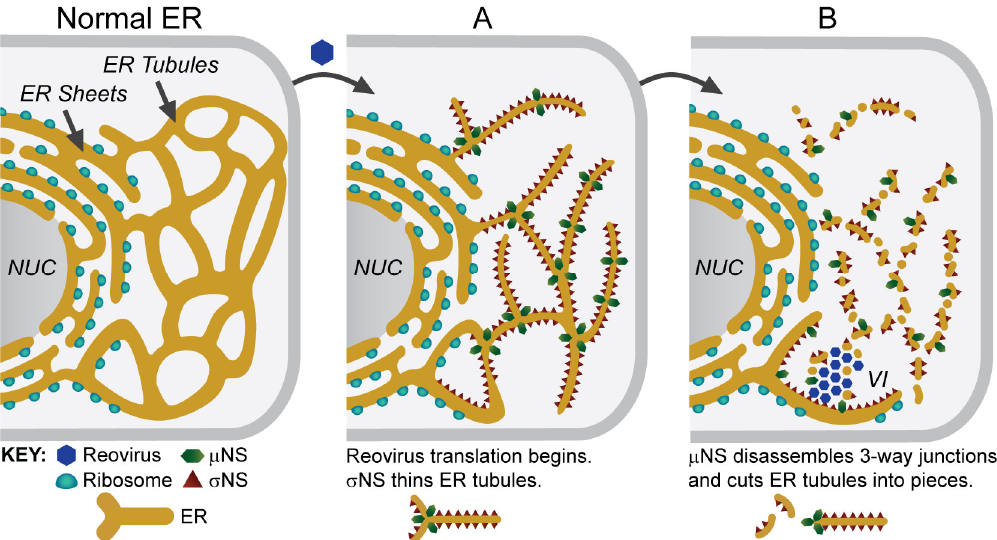
Figure 4. Model of ER remodeling and VI biogenesis. The ER in uninfected cells is composed of sheets and tubules. ( A ) In reovirus-infected cells, σNS binds to the ER tubules and transforms them into thin structures. ( B ) µNS binds to these thin tubules and triggers their fragmentation. Small tubules and vesicles coalesce to form the VI. The schematics at the bottom demonstrate how σNS and µNS might remodel the ER. NUC—nucleus. Modified from Tenorio et al., 2018 [31].